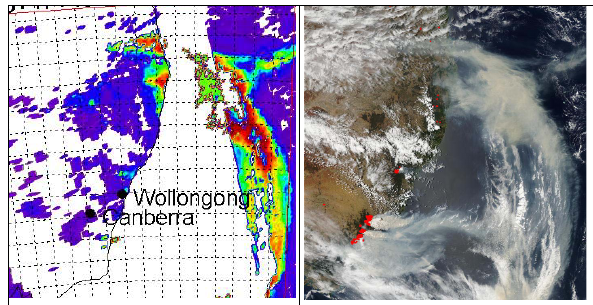
Fig. 2. Smoke plumes from the Canberra fires as seen from MODIS onboard the Aqua satellite on 18 January 2003. Left hand panel: MODIS Aerosol Optical Depth, Right-hand panel: (taken from http://rapidfire.sci.gsfc.nasa.gov/subsets/) MODIS true colour im- age with thermal anomalies shown as red pixels. Note that signifi- cant amounts of smoke visible to the eye in the right-hand panel are missed by the MODIS AOD